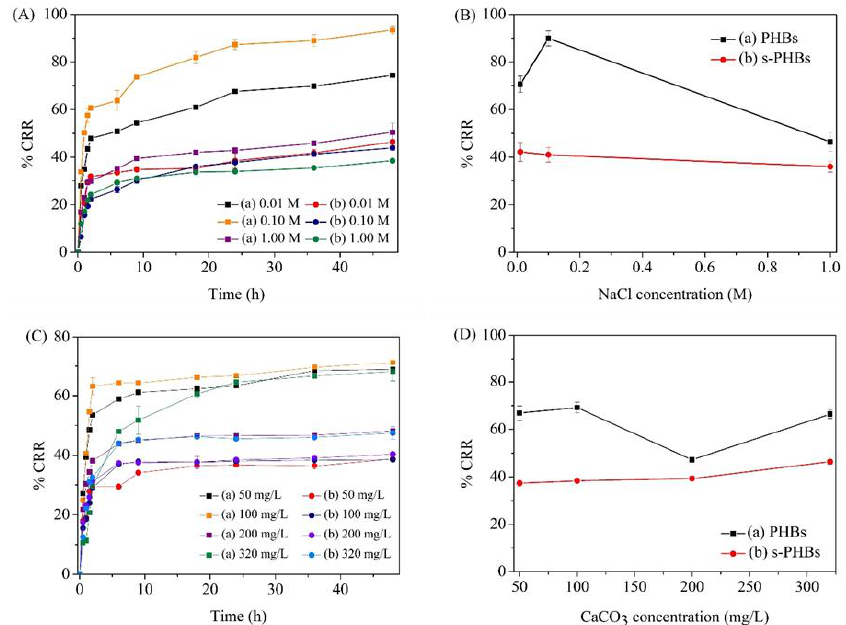
Figure 9. Effect of ionic strength on phosphate release; ( A ) the cumulative release ratio and ( B ) their corresponding plots for average phosphate release in the last 24 h of ( a ) PHBs and ( b ) s-PHBs at different NaCl concentrations. Effect of water hardness on phosphate release; ( C ) the cumulative release ratio and ( D ) their corresponding plots for average phosphate release in the last 24 h of ( a ) PHBs and ( b ) s-PHBs at different CaCO 3 concentrations.